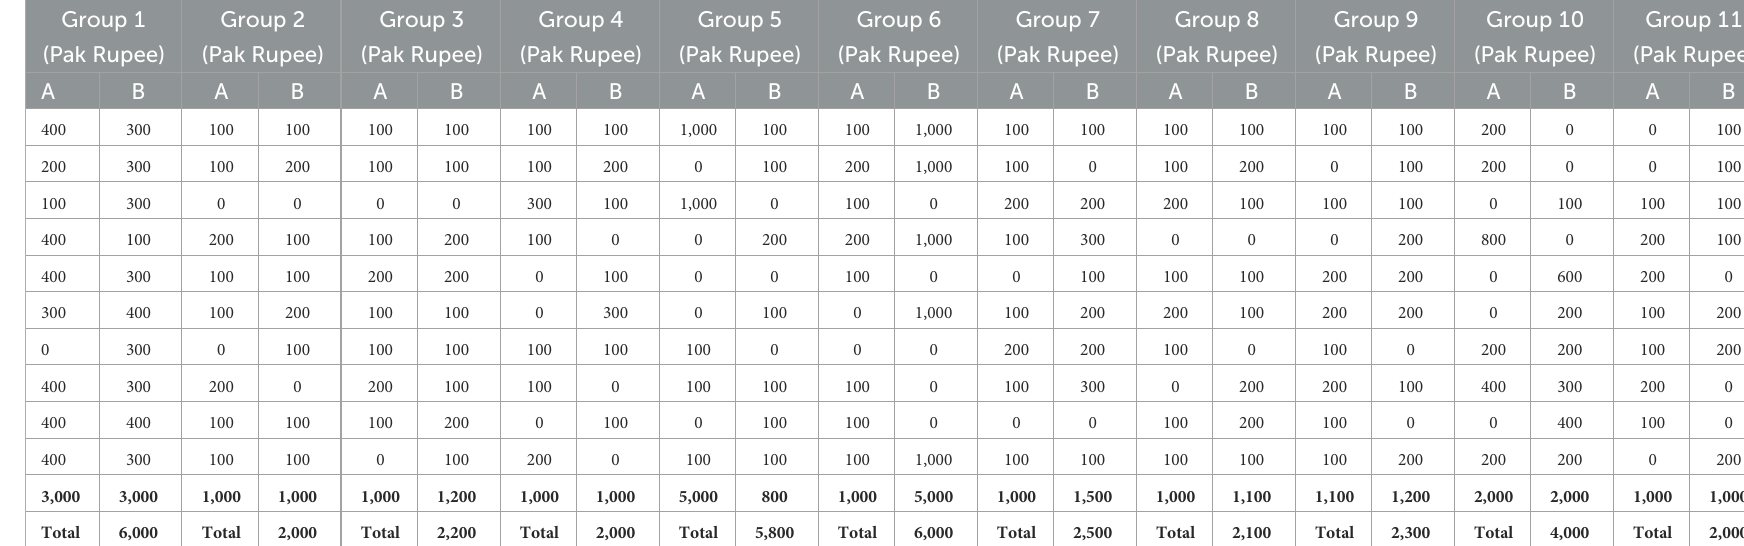
TABLE 2 Results of 10 rounds in experiment